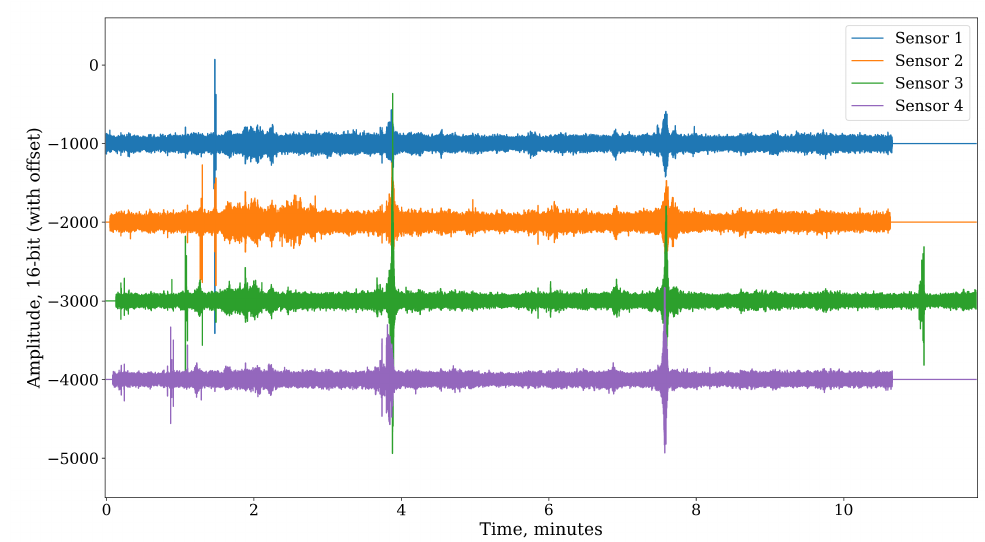
Figure 7. A sample of audio data (channel 0) synchronized across multiple sensors. Every 400 audio samples long audio data chunk can be placed in the right place on a global timeline by decoding the serialized timestamps embedded in the dedicated channel at a rate of 120 Hz.